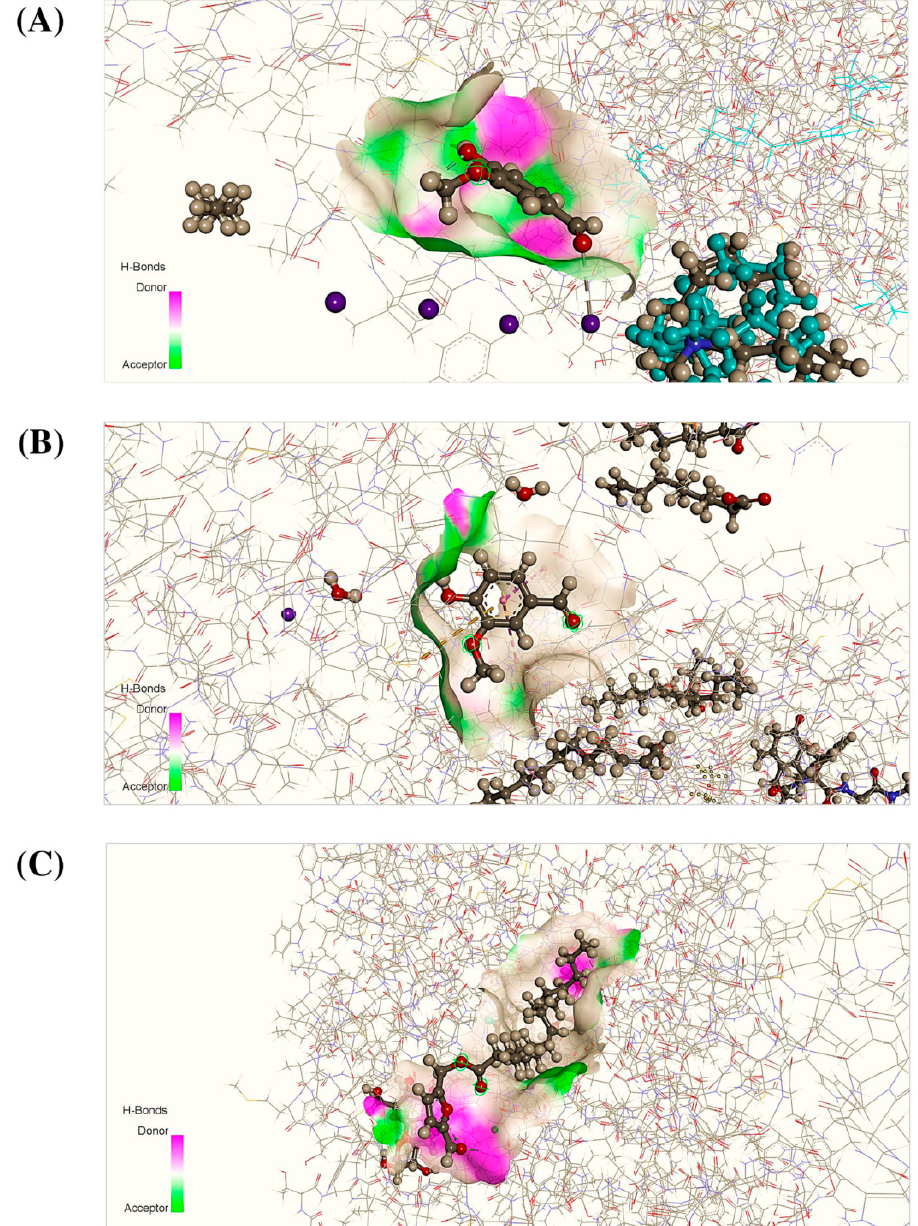
Figure 3. Three-dimensional binding interaction of vanillin with active site of 4UUJ ( A ), 4WRD ( B ), and duabanganal C with an active site of 5I6X ( C ), respectively, for anxiolytic, antidiarrheal and antidepressant